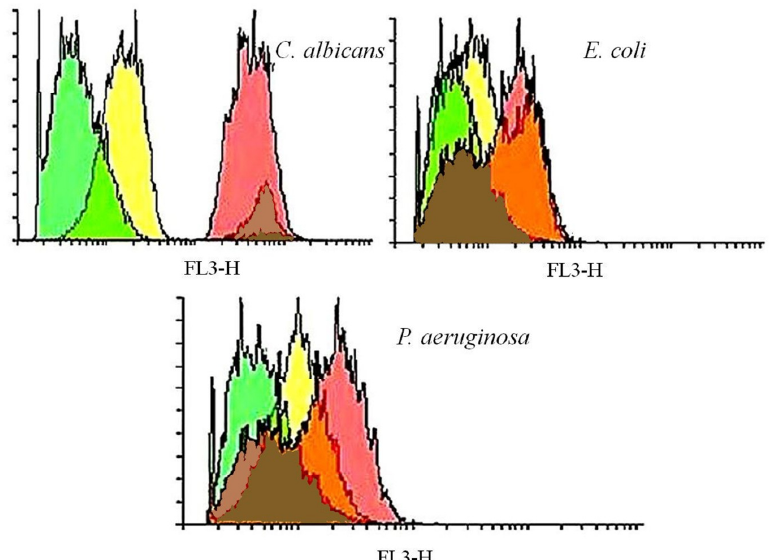
Fig. 2. Overlay of the histogram for the median of the fluorescence intensity of cell membrane integrity, viable cells control (green) and heat treated cells control (red), cells treated with O. europaea fatty oil (yellow); a, b, c, d - typical aspects of the histograms obtained at MIC/2 concentration values for C. albicans , E. coli , P. aeruginosa , S. aureus ,